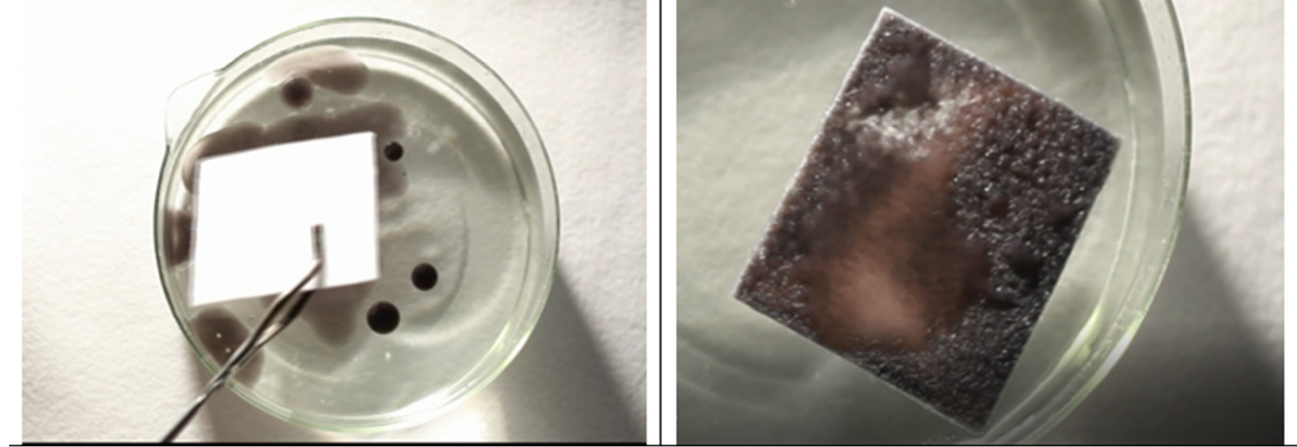
Figure 9. ( Left ): An oil-binding non-woven is brought in contact with oil in water. ( Right ): The material has captured the oil but did not become wet from the water.